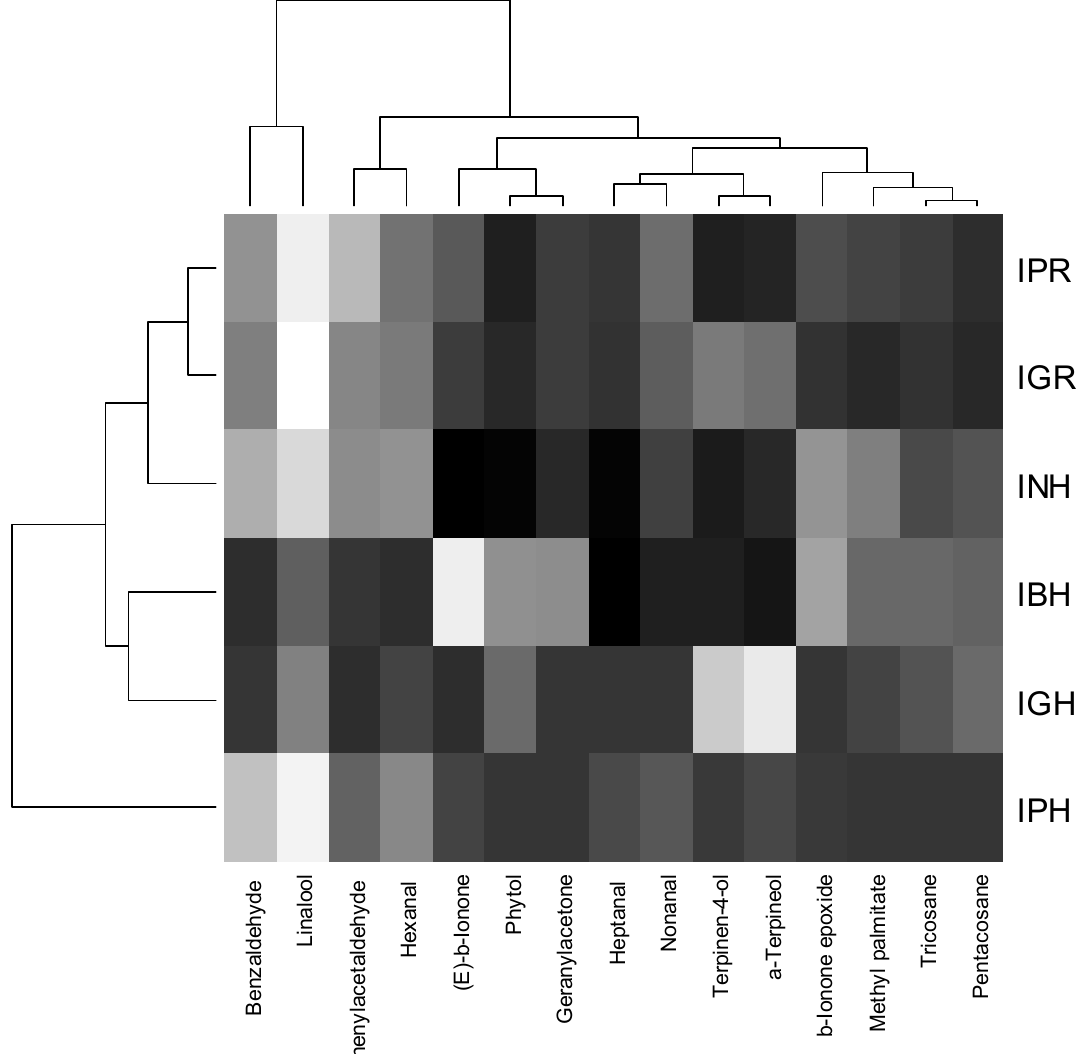
Figure 1. The heatmap analysis of the essential oil constituents. IBH, I. balsamina herb; IGH, I. glandulifera herb; IGR, I. glandulifera roots; INH, I. noli-tangere herb; IPH, I. parviflora herb; IPR, I. parviflora roots.